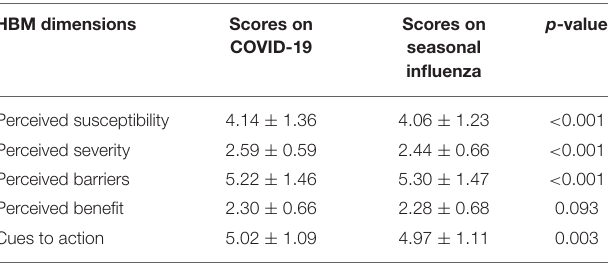
TABLE 4 | Comparison of scores regarding the five dimensions of HBM between COVID-19 vaccination and seasonal influenza